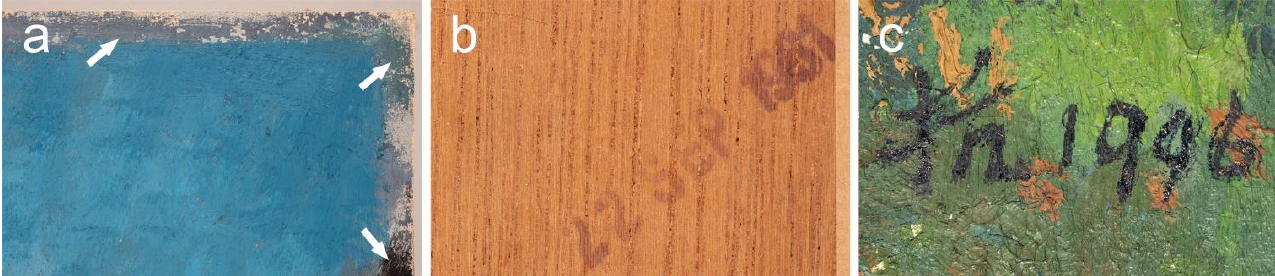
Figure 4. Details of Mount Huangshan , 1996, showing the: ( a ) underlying paint scheme indicated by the arrows; ( b ) date stamp on the back of the plywood auxiliary support; ( c ) artist’s signature “Kang” and date “1996” on the painting.